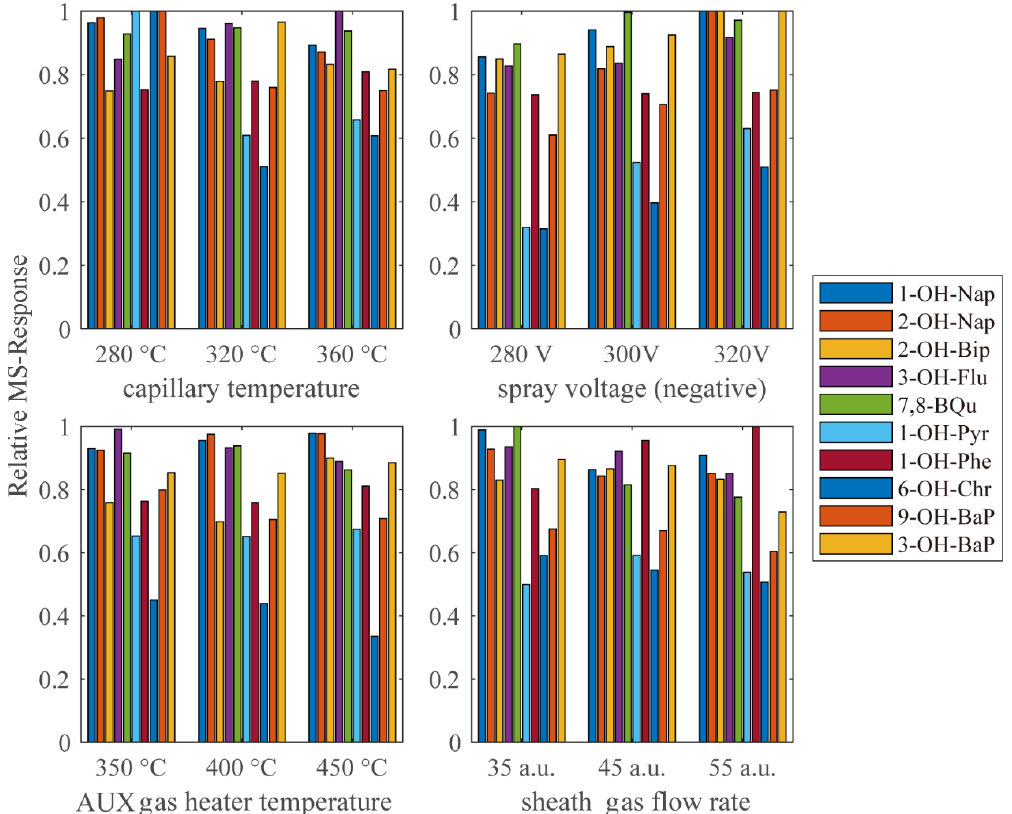
Figure 4. The MS–response relative to the highest response in each group under different HESI parameters. Table 3. RT, linear range, correlation coefficients (r 2 ), LOD, LOQ and instrument RSD ( n = 7) of each